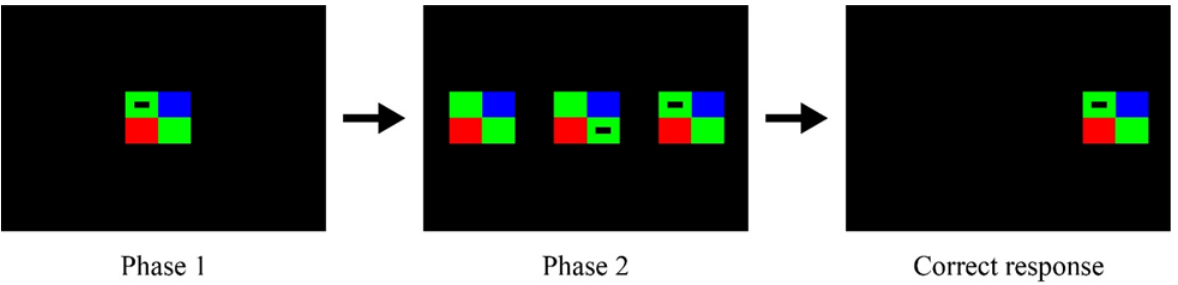
Example Trial for the Delayed Match-to-Sample (DMS) Task